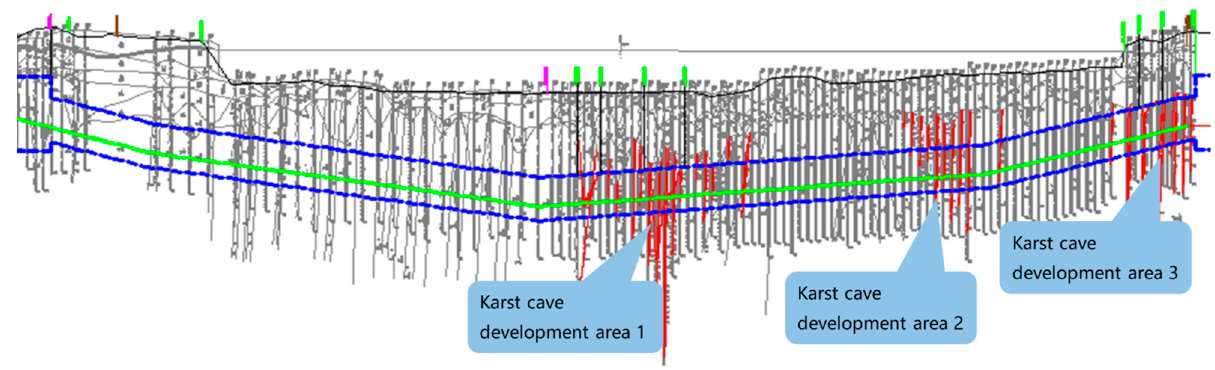
Figure 7. Profile view of the undersea tunnel.